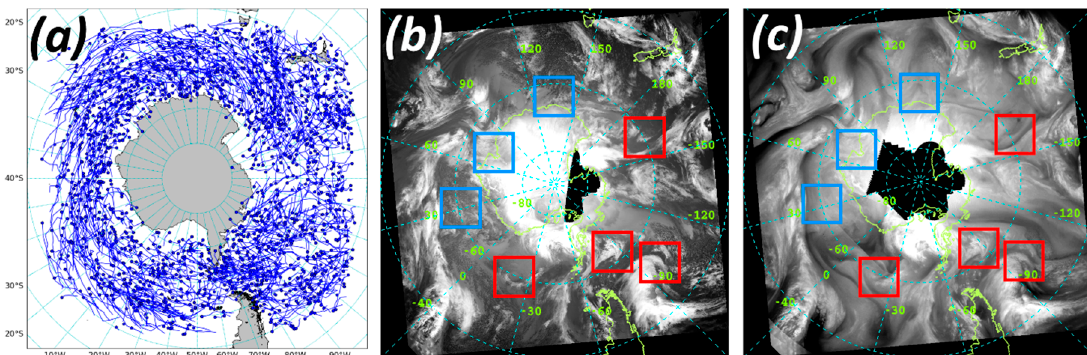
Figure 1. The input for the deep convolutional neural networks (DCNNs). ( a ) Trajectories of all mesocyclones (MCs) in Southern Ocean MesoCylones (SOMC) dataset, blue dots mark the point of generation of MC. Snapshots of satellite mosaics for SH for ( b ) InfraRed (IR) and ( c ) Water Vapor (WV) channels at 00:00 UTC 02/06/2004. The red/blue squares indicate patches centered over the MCs (red squares) and those having no MC cloudiness signature in (blue) being cut from the mosaics for DCNNs